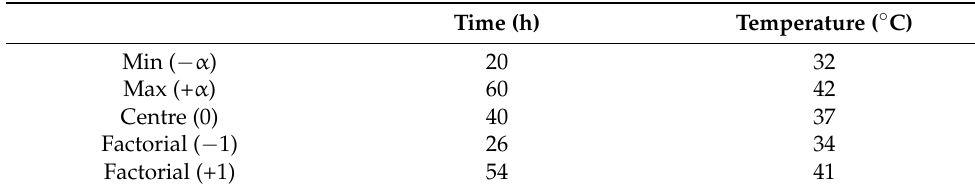
Table 1. Definition of the circumscribed central composite design independent variable values. The α value related to ± 1 is equal to ±